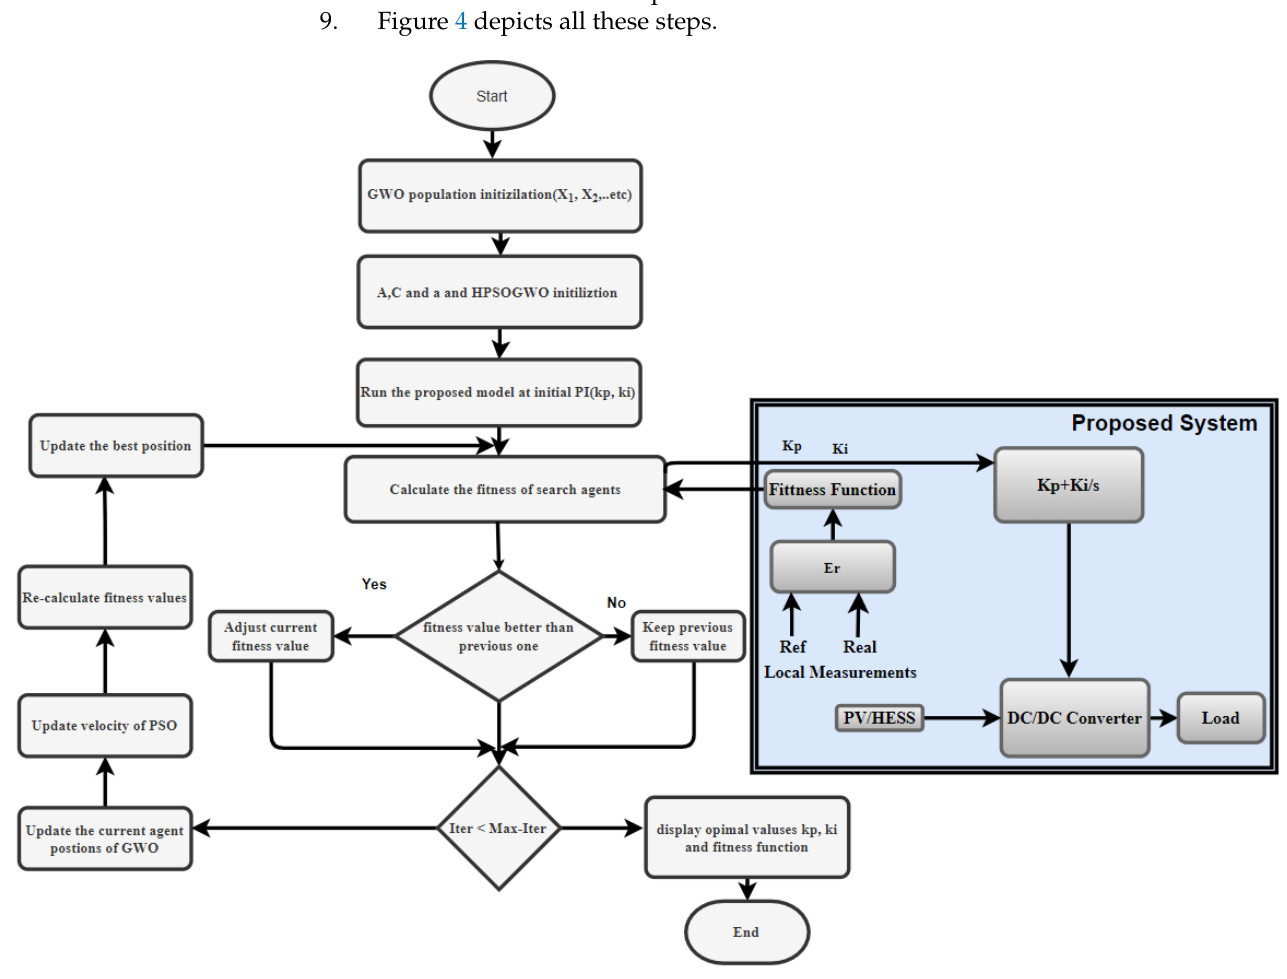
Figure 4. HPSO–GWO flowchart.